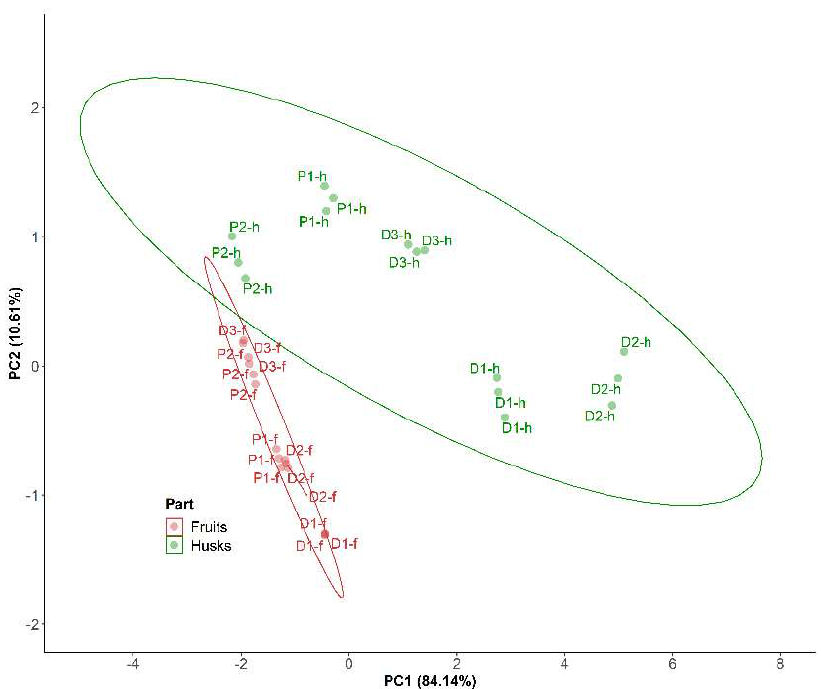
Figure 23. Plane defined by two first principal components (PC1 and PC2) resulting from PCA analysis of P. peruviana sample ( n = 10). Regions: Dota (D) and Paraiso (P). Parts: husks (h) and fruits (f).